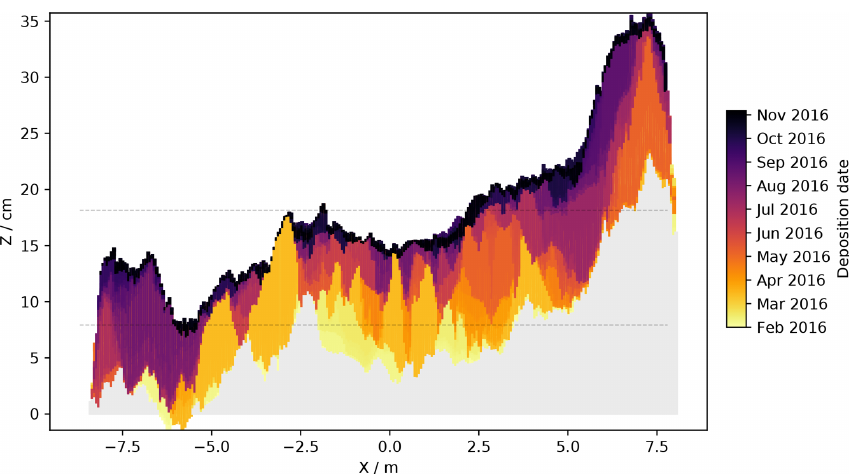
Figure 13. Snowpack internal structure along the transect parallel to the x axis at Y = 4m deduced over the period February 2016– February 2017 (period 2a). The color indicates the date of deposition of the layer. The gray shade corresponds to snow older than the first acquisition of RLS in this period. The two gray lines represent the scanned-area average surface elevation at the beginning and end of period